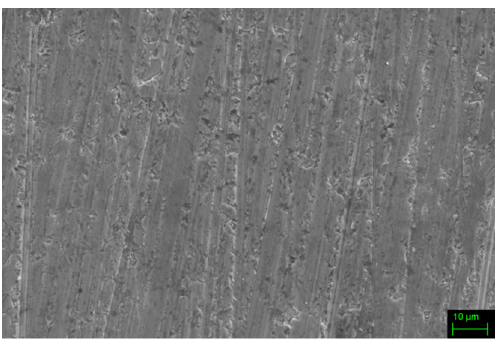
Figure 4. SE-SEM microphotograph taken on dense Fe70 sample.